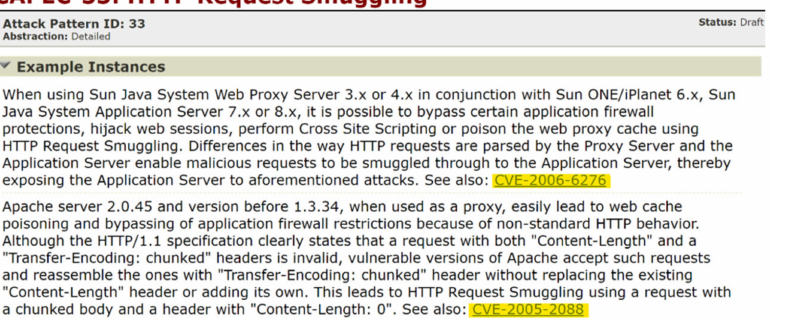
Figure 5. CAPEC-33 web page (https://capec.mitre.org/data/definitions/33.html, accessed on 16 June 2021).